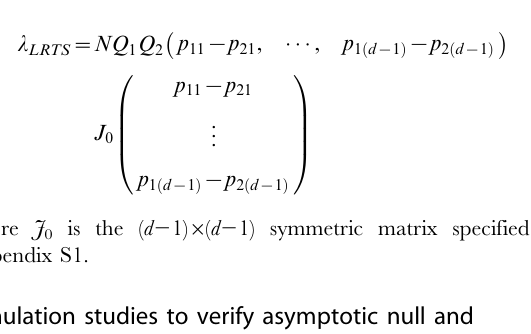
Table 2. Simulation results of the null distribution of LRTS .